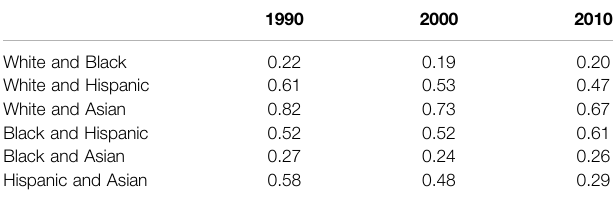
Figure 3 shows that income inequality between white and black citizens is more signi fi cant in the Overlap zone than in the zones 100% white and black.